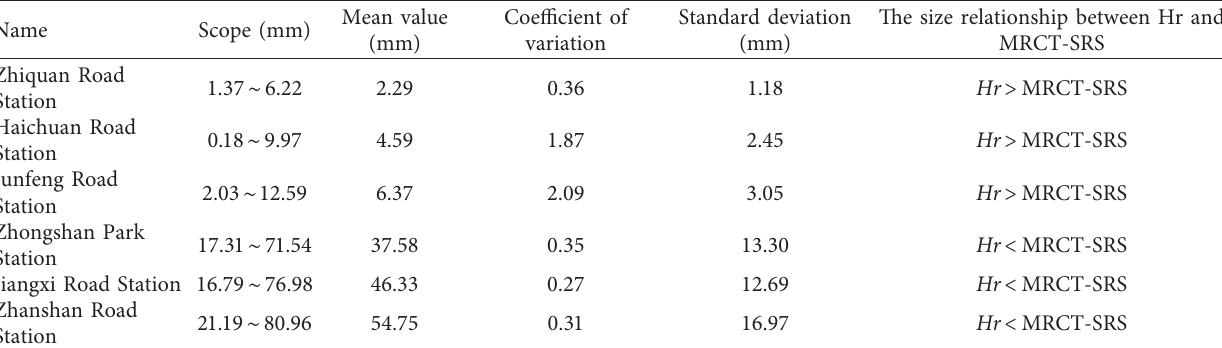
Table 9: Statistical table of ground surface settlement of the station